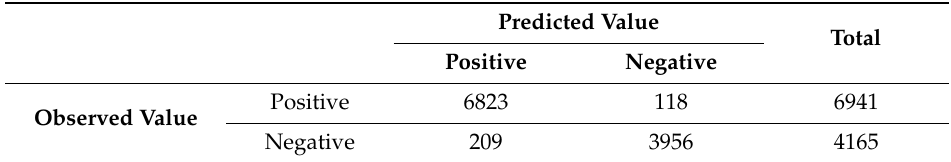
Table 3. The confusion matrix of the ResNet-101 + FPN model (two